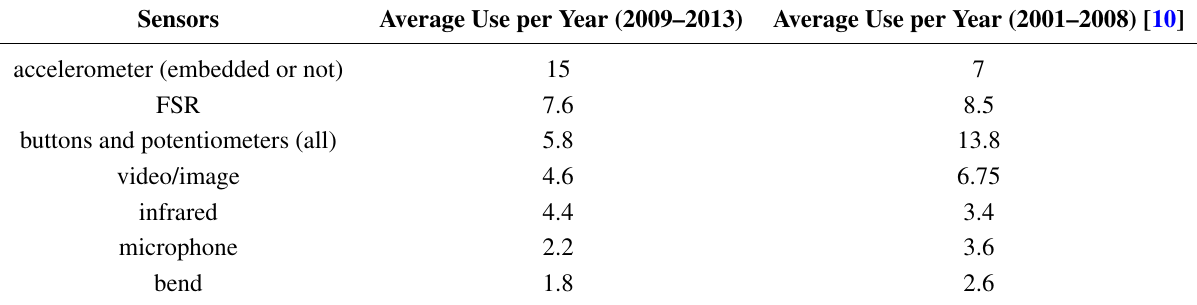
Table 2. Average use per year, compared with previous study [10].